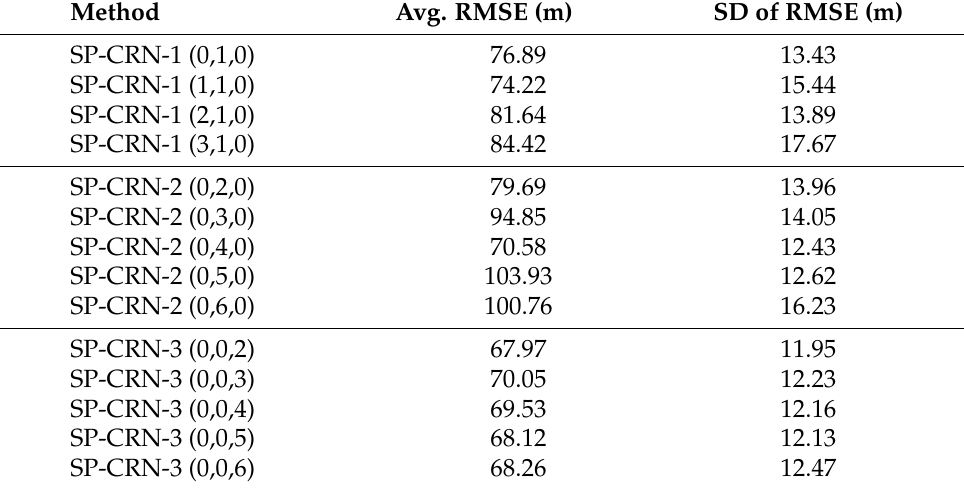
Table 1. Evaluation of different settings on the ZH300 prediction for SP-CRN with three propos- als. The settings ((x, y, z) are the numbers of the nearby-time of PRD-1, periodic-depth of PRD-2, and periodic-depth of PRD-3, respectively. The SP-CRN-1, SP-CRN-2, and SP-CRN-3 indicate each proposal in SP-CRN which was a nearby-time representation, periodic-depth representation, and periodic-depth differencing representation, respectively. The highlighted result in blue is the best prediction accuracy for each proposal, while the gray highlight in the SP-CRN baseline